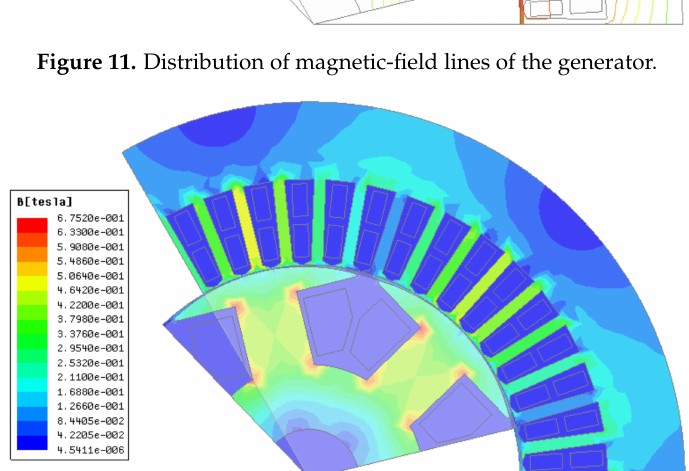
Figure 12. Magnetic-density distribution map of the